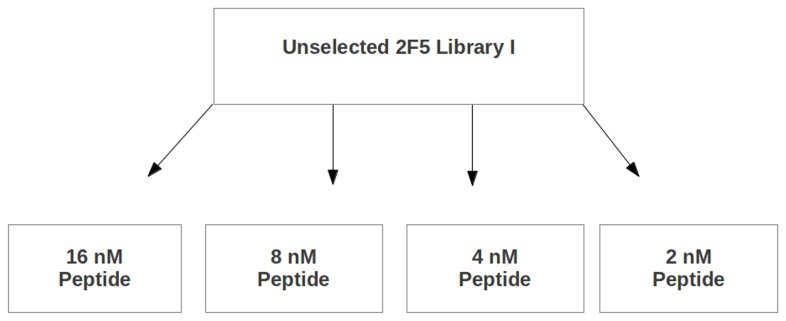
Docking of HRV14 (shown in yellow) with a crystallographic structure (1TZG from the Protein Data Bank) of a complex of the 4E10 Fab (orange) complexed with the cognate Ac-KGWNWFDITNWGK-NH2 peptide (blue ribbon and gold stick-and-balls model).Docking provides ideas for how to connect the 4E10 epitope to the surface of HRV.